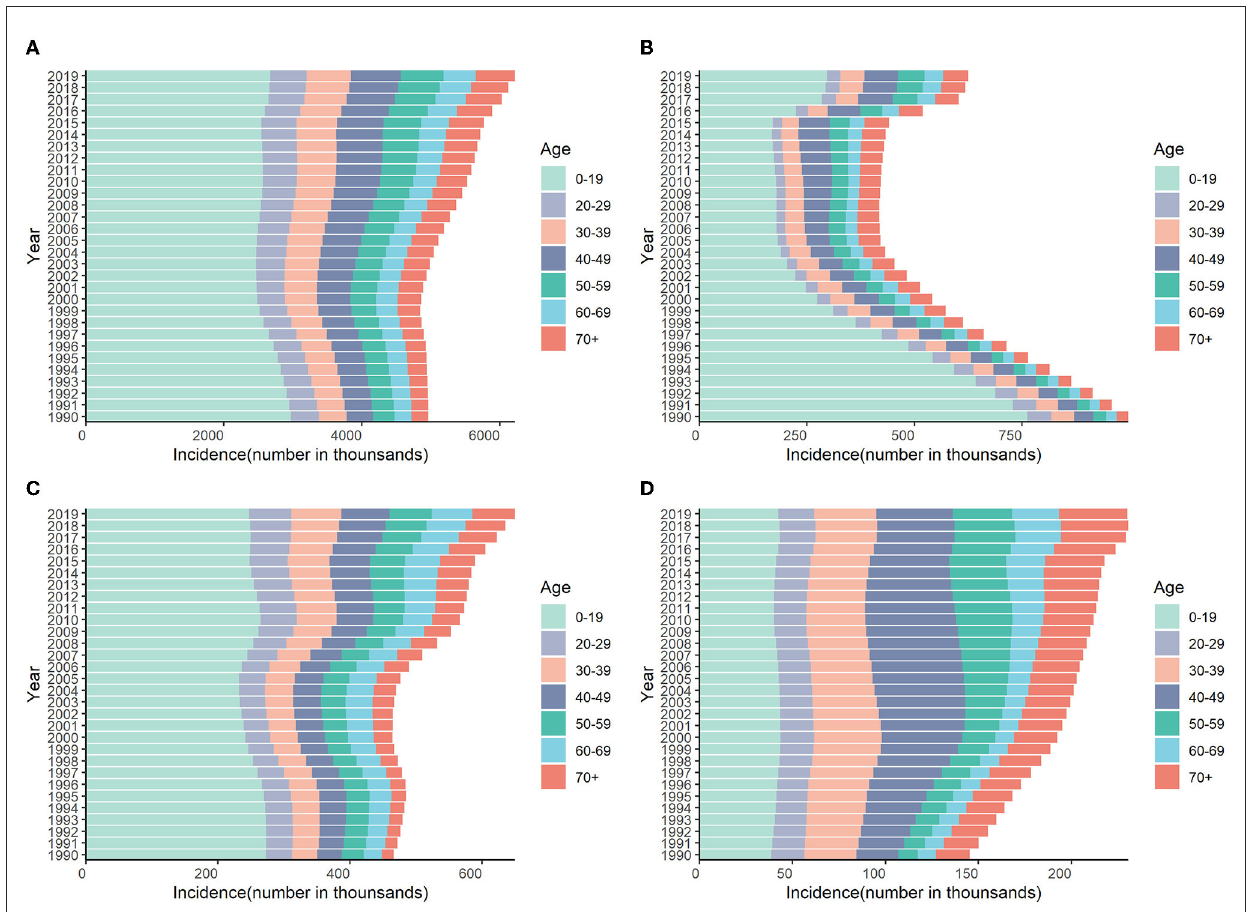
FIGURE7 Numbers of incidences attributable to HCV by age groups in different regions from 1990 to 2019. (A) Global; (B) China; (C) India; (D) the United States.